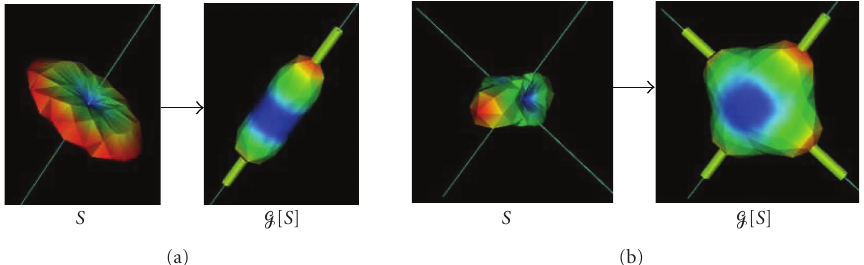
Figure 1: Funk-Radon transform G illustrated for the input di ff usion attenuation signal S ( b = 1000 s/mm 2 ) with 1 fiber (left) and two orthogonal fibers (right). The thin lines are the true underlying fiber directions and the thicker tubes are the detected maxima. One must imagine these functions as living on the surface of the sphere. Here, for visualization purposes, the radius of the respective spheres are scaled by the corresponding value on the surface. Blue-to-red colors represent low-to-high spherical